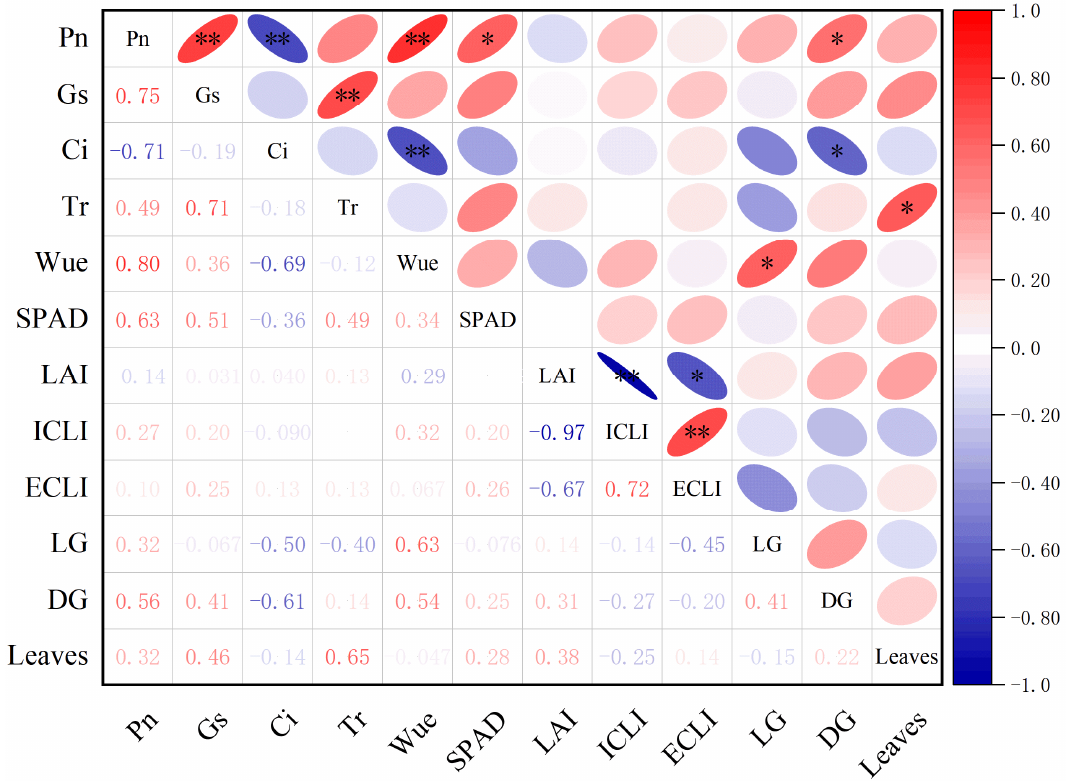
Figure 4. Correlation analysis among physiological growth indexes. ** At the 0.01 level, there is significant correlation. * At the 0.05 level, the correlation is significant. The red ellipse represents a positive correlation between the two coefficients, while the blue ellipse represents a negative correlation. The flatter the ellipse, the greater the correlation coefficient. Table 5. Eigenvalues and contribution rates of three principal components